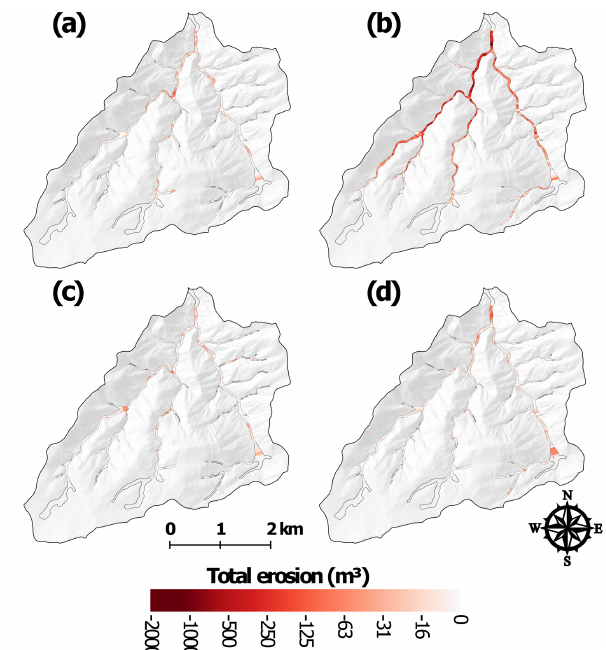
Figure A4. Total erosion for each valley bottom segment in Skin Gulch for (a) 201210–201307, (b) 201307–201310, (c) 201310–201409, and (d) 201409–201506. Calculated volumes are not reported for the transparent segments due to unrealistically wide valley widths, repeat excavations, or the ground surface not being reliably